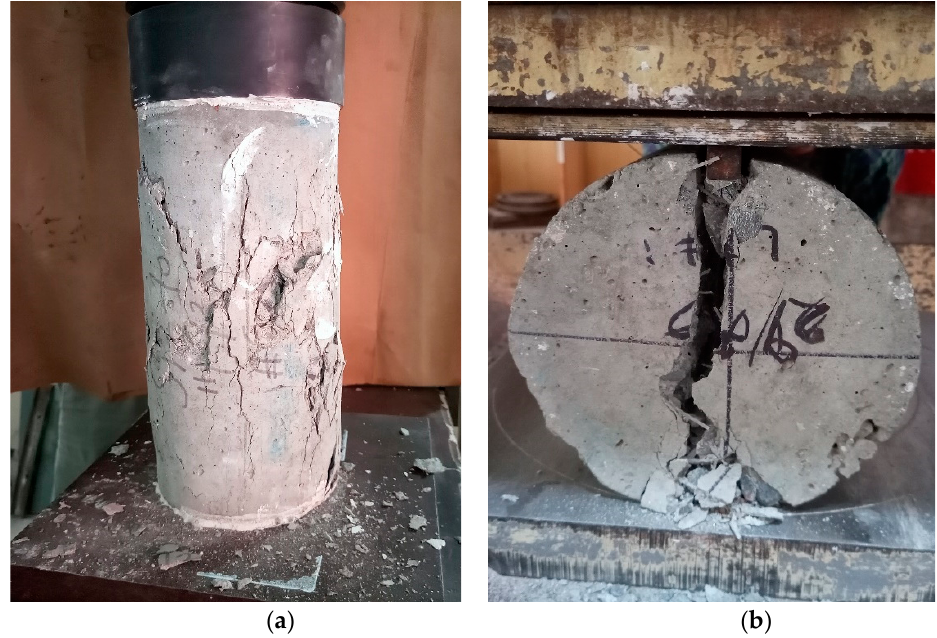
Figure 6. Tested fiber ‐ reinforced cylinders: ( a ) compression test, ( b ) splitting tensile strength test.